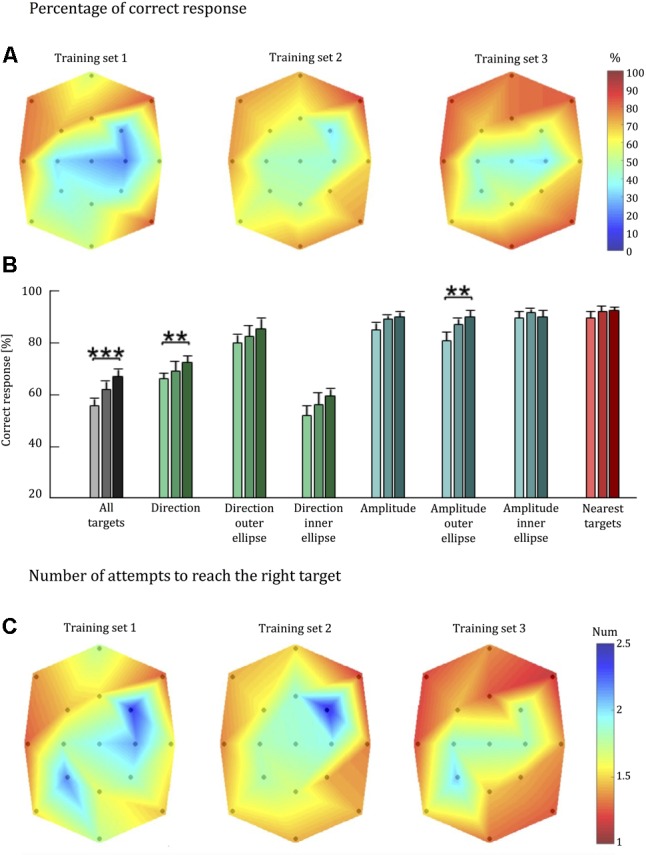
Tactile acuity of healthy individuals during training with the Tactile-STAR. (A) Colormap of the percentage correct responses as in Figure 5. (B) Population average percentage correct responses as in Figure 5B. (C) Colormap of the number of attempts needed to correctly identify the stimulus. Colors closer to blue indicate a larger number of wrong attempts to identify the stimulus. ∗∗p < 0.01, ∗∗∗p < 0.001.